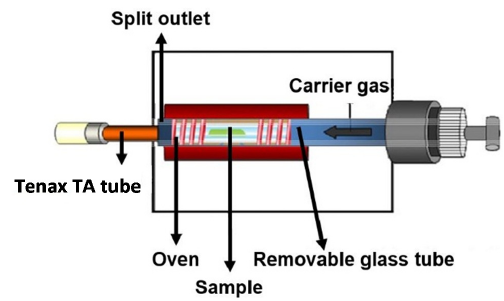
Figure 2. Schematic diagram of the thermal extractor (TE).